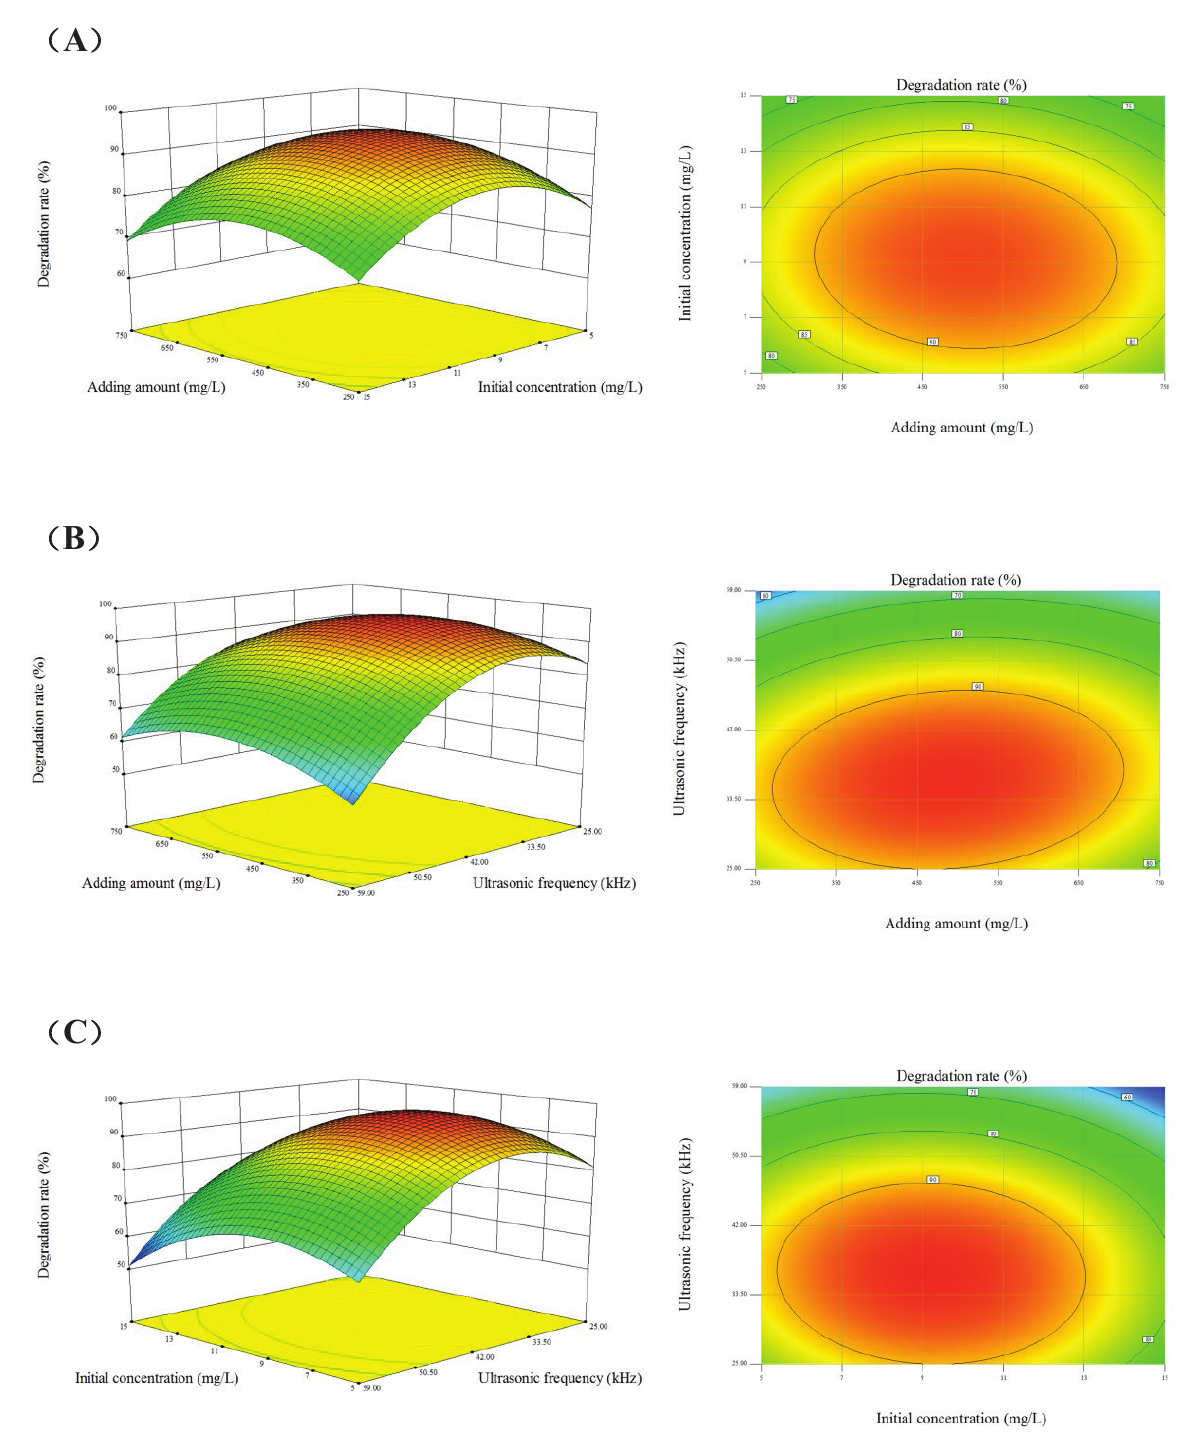
Figure 9: Response surface figure (3D) and contour plots of the sonocatalytic degradation of methylorange by Fe-doped TiO powder catalyst as a function of (A) adding amount and initial concentration, (B) adding amount and ultrasonic frequency, (C) initial concentration and ultrasonic frequency.